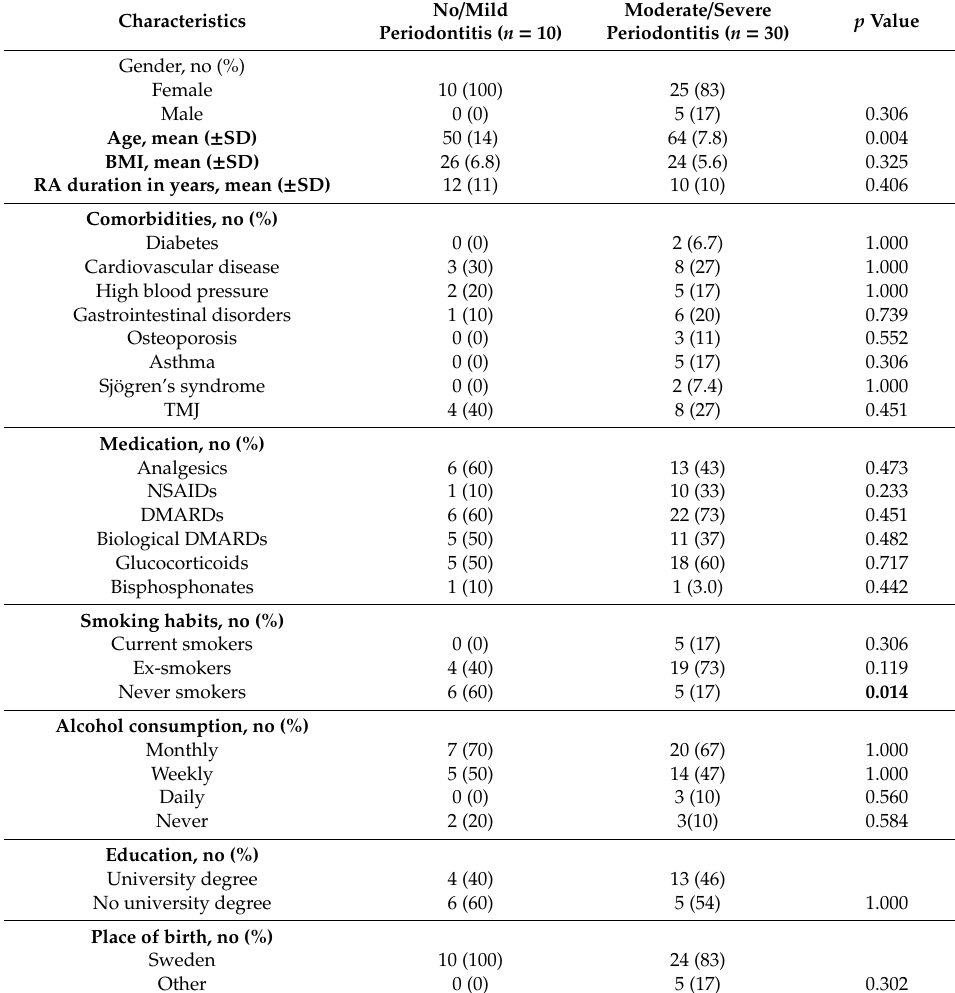
Table 1. Characteristics of subjects with rheumatoid arthritis (RA) in relation to periodontal diagnosis.